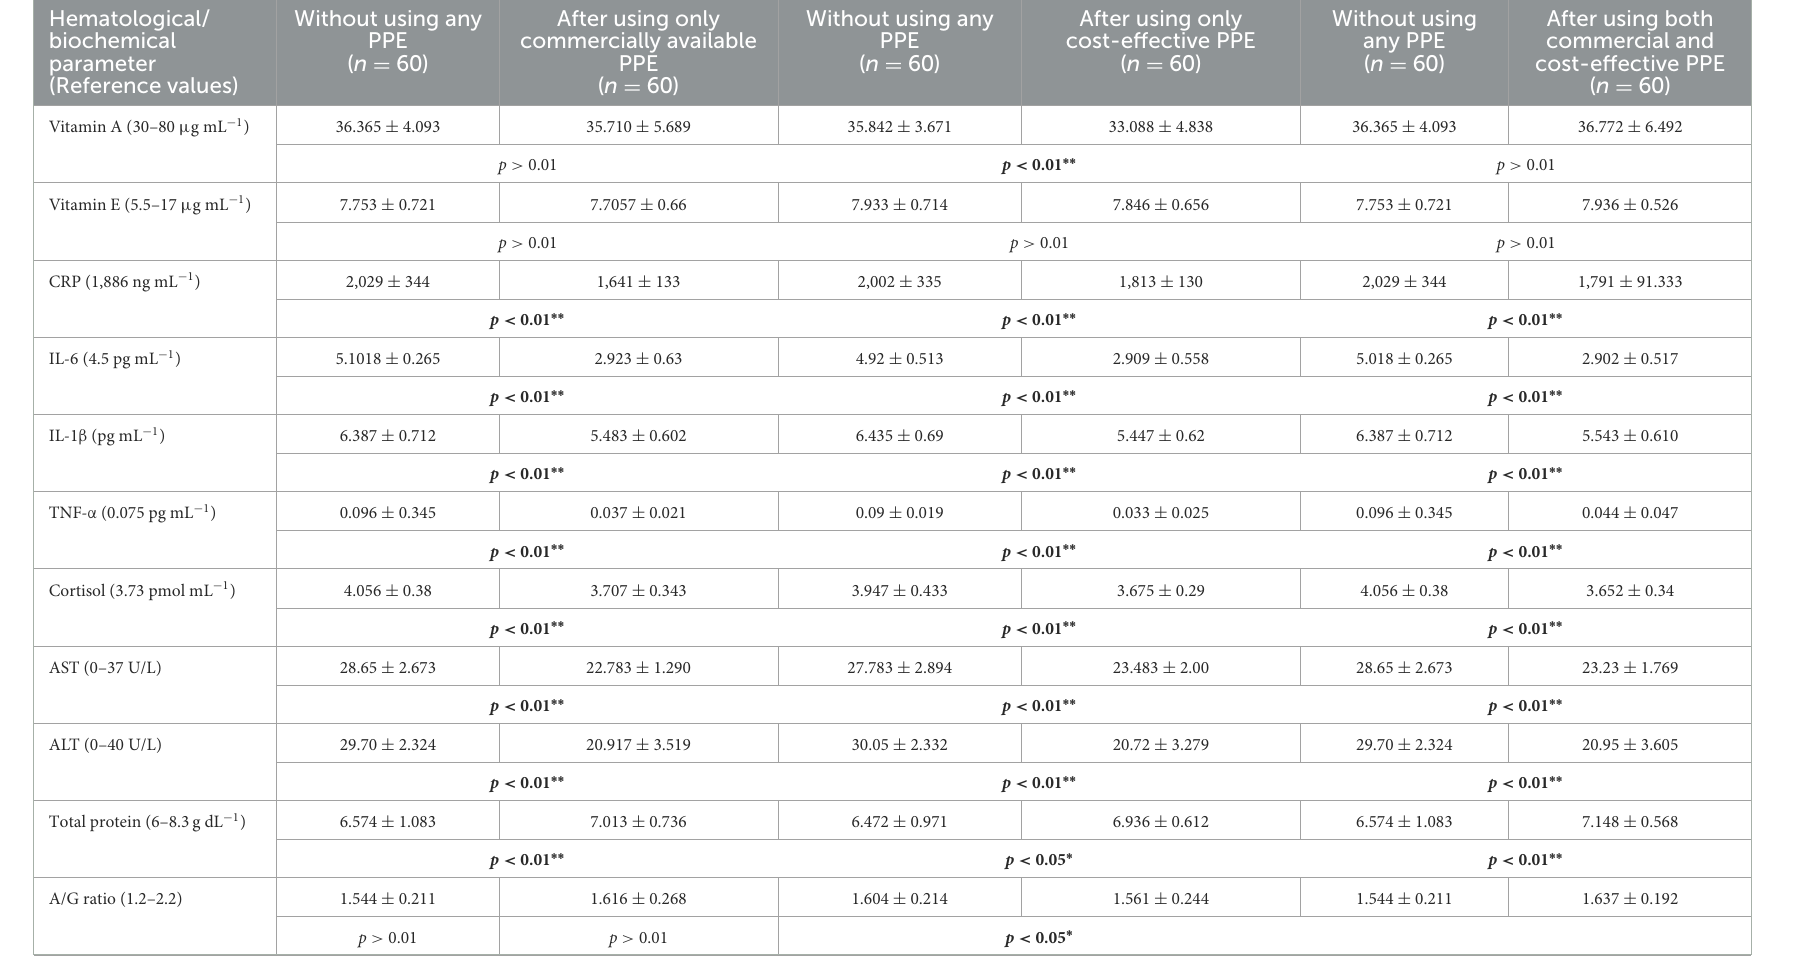
Without using any After using only PPE commercially available